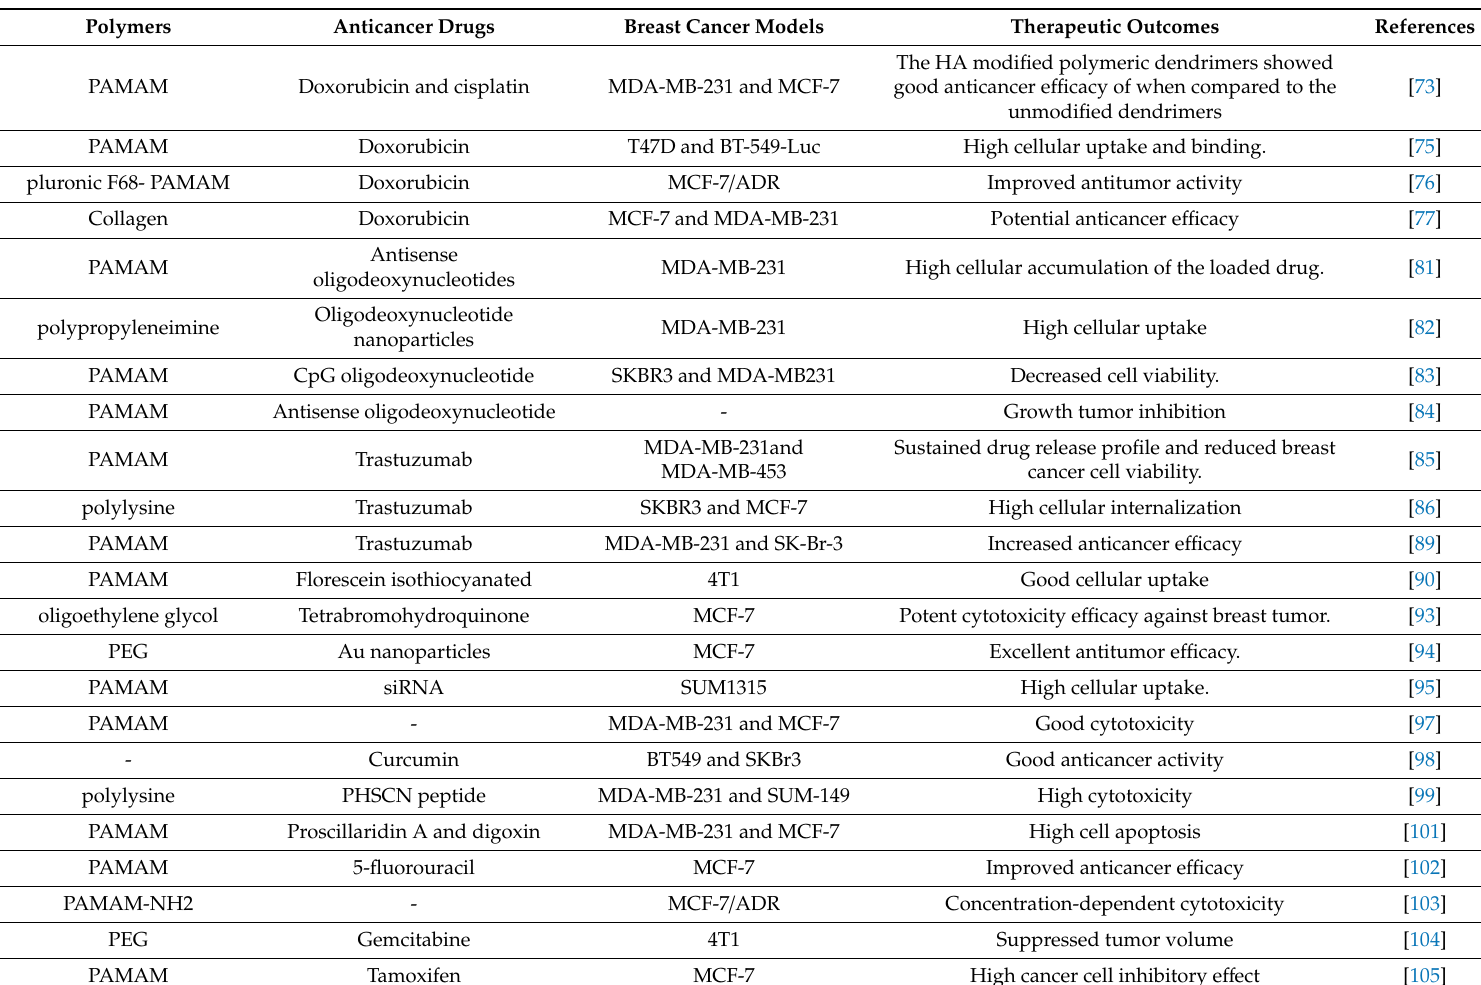
Table 3. A summary of polymeric dendrimers nanocarriers loaded with anticancer drugs for breast